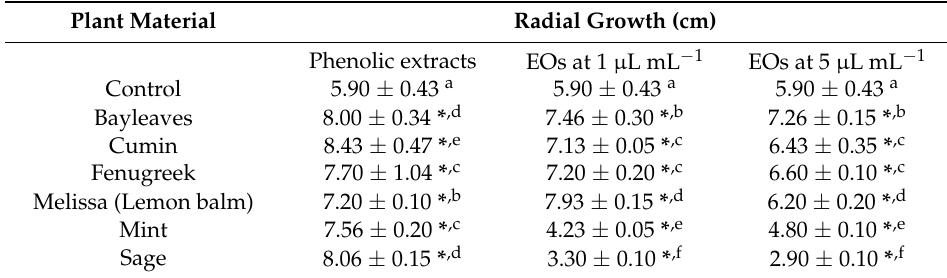
Table 1. Radial growth (cm) of Aspergillus carbonarius S402 after four days of culture at 28°C on Synthetic Grape Medium (SGM) supplemented with the phenolic extracts at 250 µg GAE mL − 1 as well as essential oils (EOs) at 1 and 5 µL mL − 1 each, compared to a control.